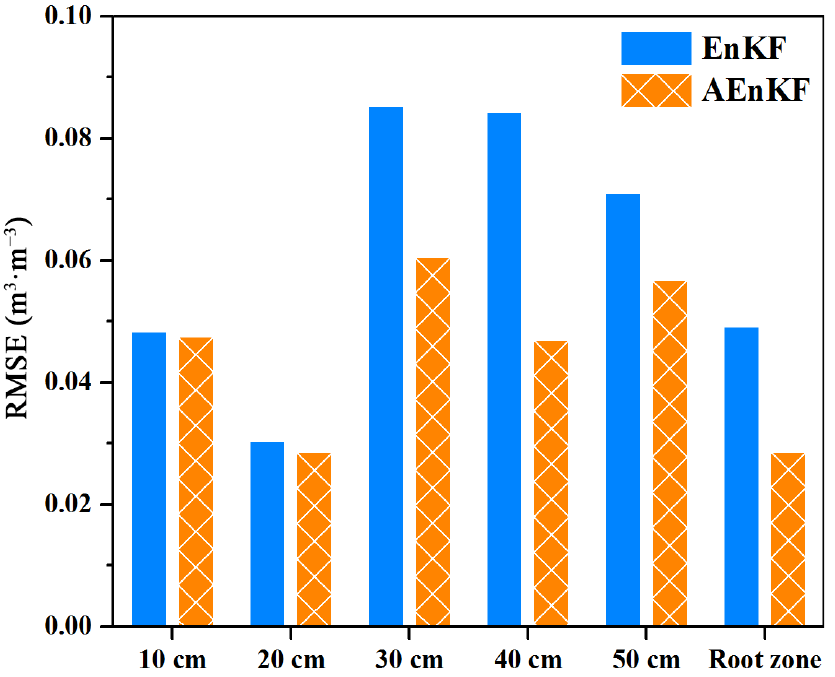
Figure 5. Root-mean-square errors ( RMSEs ) of assimilated soil moisture at different soil depths using AEnKF and EnKF algorithms.